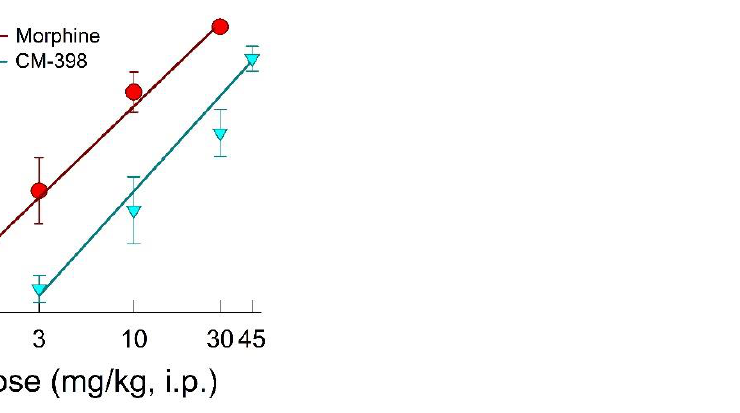
Figure 2. Dose-dependent antinociception of sigma-2 receptor ligand CM-398 following i.p. admin- istration in the mouse acetic acid writhing test. Opioid agonist morphine is shown as a positive control. All points represent average response ± SEM at peak effect, 30 min after admin in 8 – 10 mice. ED 50 values analyzed using linear regression.